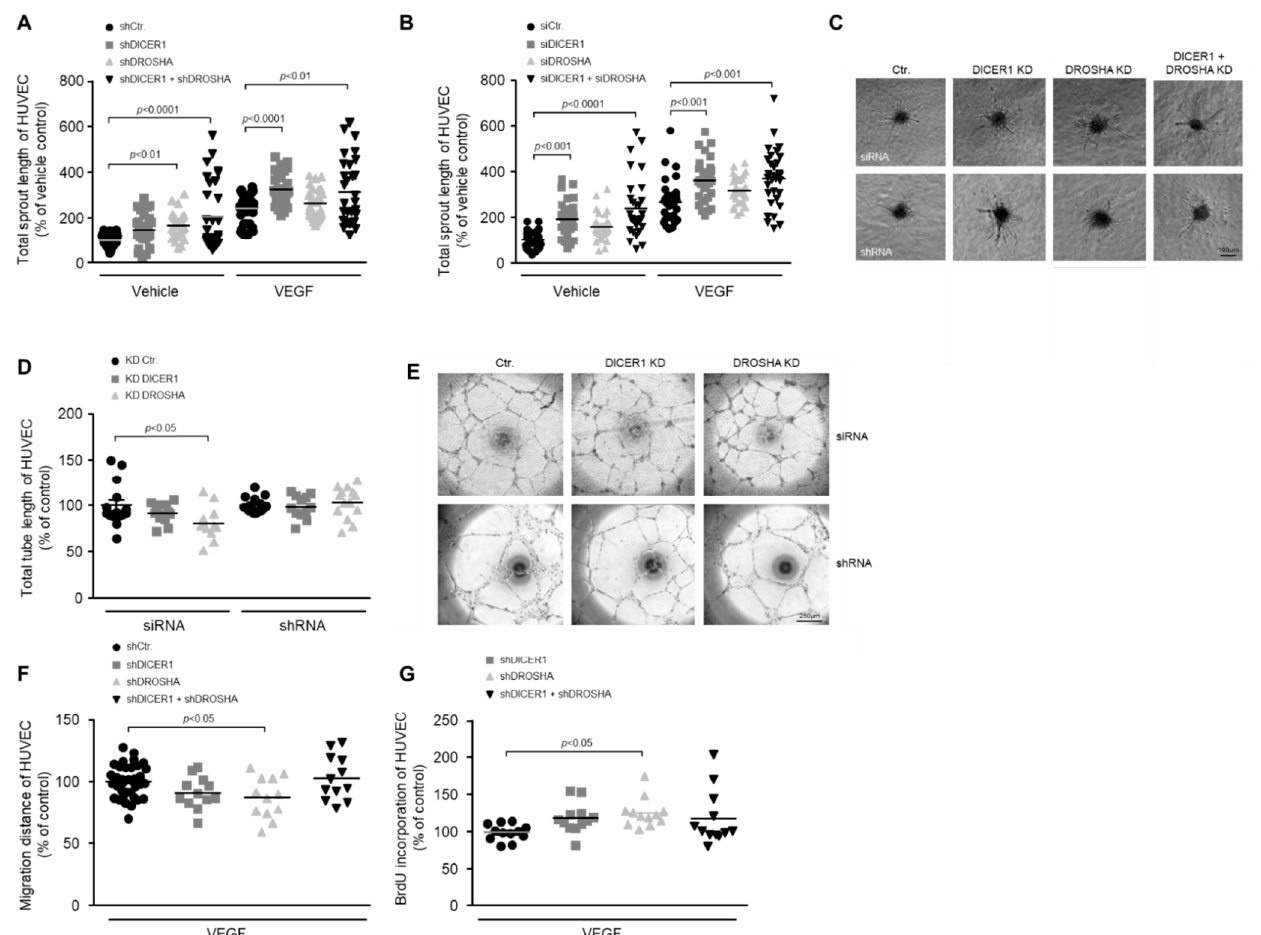
Figure 2. Impact of RNAi-mediated knockdown of DICER1 and/or DROSHA on the angiogenic capacity of HUVEC in vitro . RNAi-mediated knockdown of DICER1 as well as DICER1 and DROSHA using either specific shRNA ( A , C ); n = 30–52) or siRNA ( B , C ); n = 29–30 biological replicates derived from at least three independent sets of experiments) increases basal and VEGF-induced sprouting from HUVEC spheroids in vitro . Data are depicted as scatter plots and mean. ( C ) Representative microscopic pictures of VEGF-induced (20 ng/mL) HUVEC spheroid sprouts. RNAi-mediated knockdown of DROSHA but not DICER1 using either specific shRNA or siRNA may slightly decrease HUVEC migration ( F ); n = 12–36 biological replicates derived from at least three independent sets of experiments) and tube formation ( D , E ); n = 12–15 biological replicates derived from at least three independent sets of experiments), although the siRNA-related knockdown effect on the tube formation capacity of HUVEC could not be observed in HUVEC, in which DROSHA knockdown was performed using shRNA ( D ). ( E ) Representative microscopic pictures of HUVEC tubes. ( G ) shRNA-mediated knockdown of DROSHA but not DICER1 moderately increases BrdU incorporation of HUVEC ( n = 12 biological replicates derived from at least three independent sets of experiments).